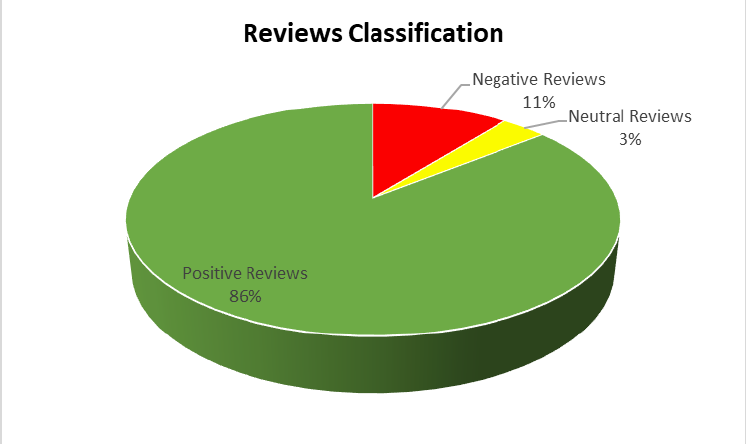
Figure 5. Classification of the reviews using polarity value.